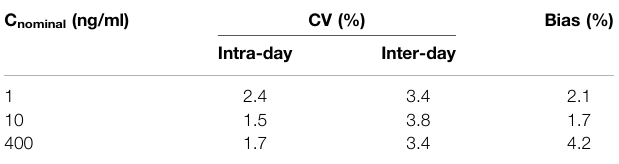
TABLE 1 | Precision and accuracy of TFV in human breast